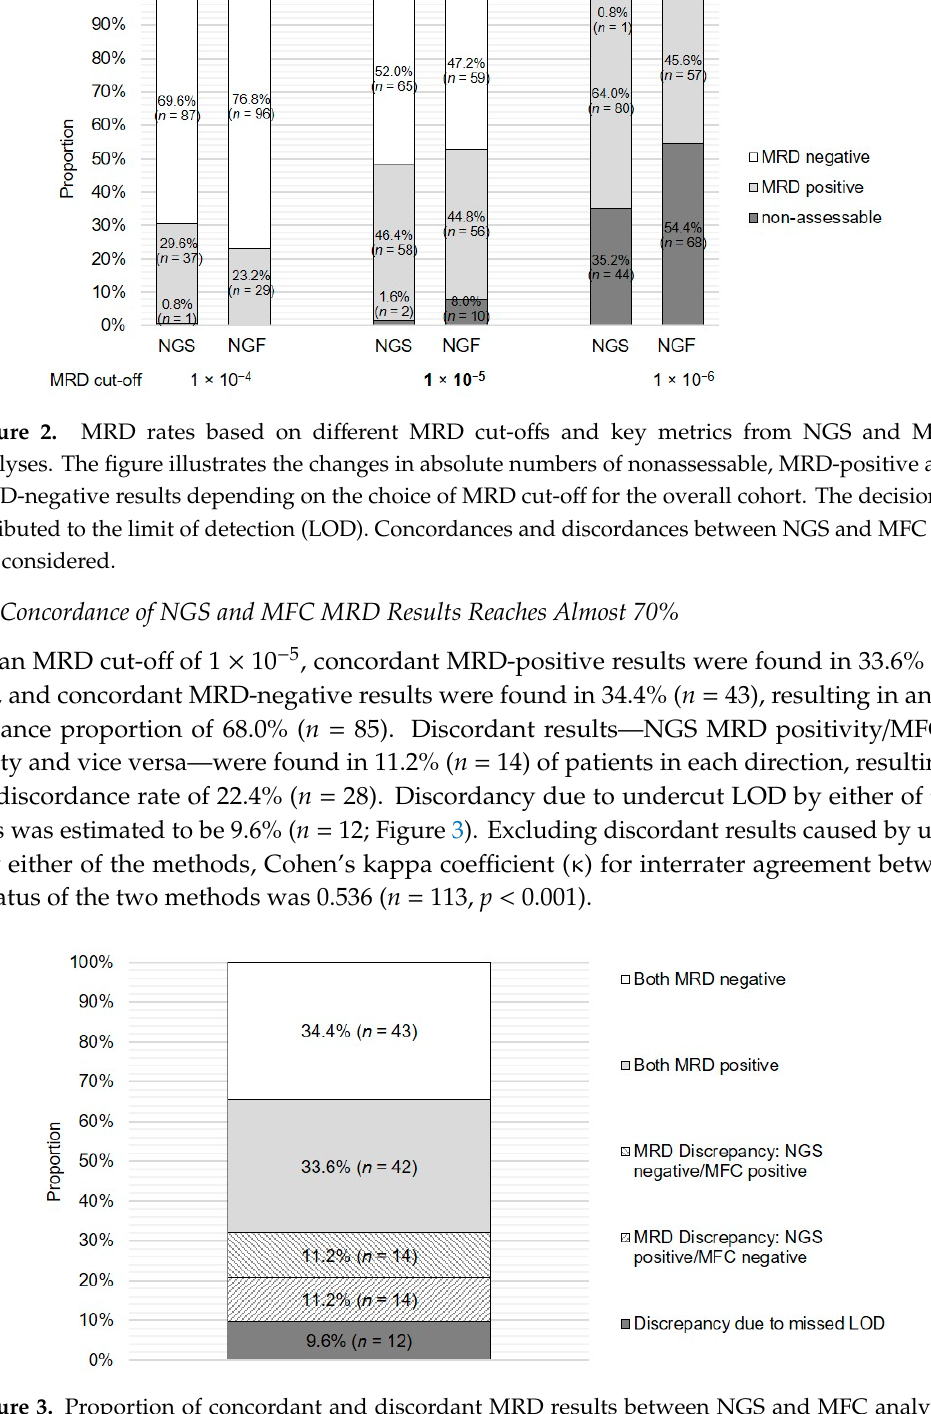
Figure 3. Proportion of concordant and discordant MRD results between NGS and MFC analyses. Relative and absolute numbers of concordant and discordant MRD results obtained from NGS and MFC assays at an MRD cut-o ff of 1 × 10 − 5 are shown. LOD, limit of